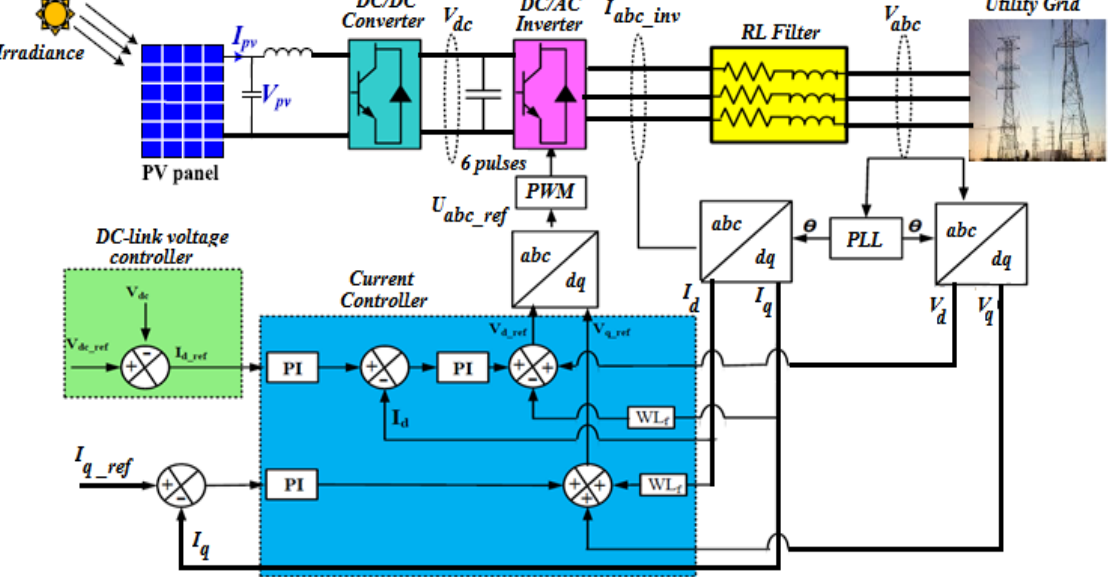
Figure 7. Proposed scheme of DC/AC inverter.